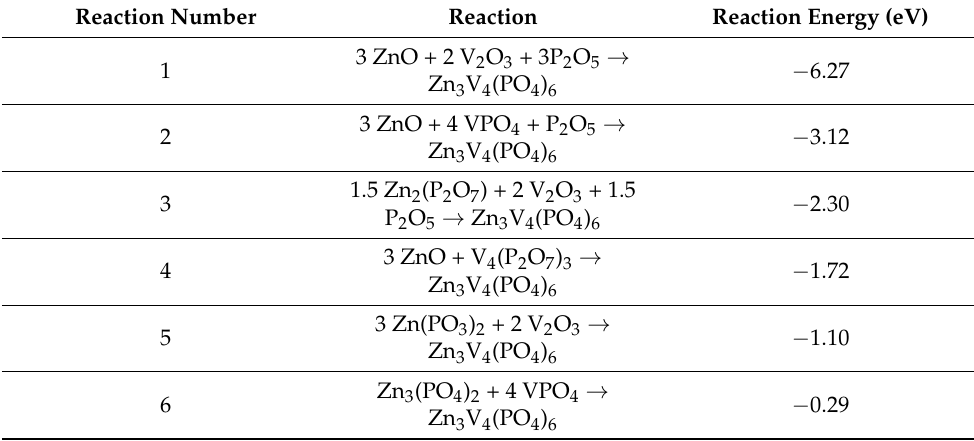
Table 6. Different reaction routes for the synthesis of Zn 3 V 4 (PO 4 ) 6 . Reaction Number Reaction Reaction Energy